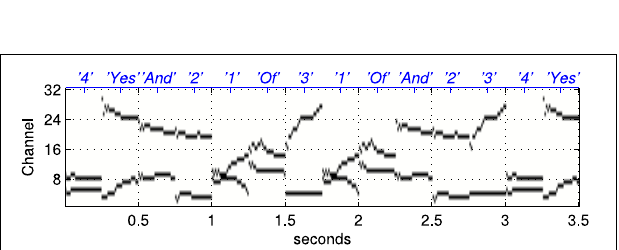
FIGURE 5 | An example of a stimulus sequence, or “sentence,” used as a Probe Stimulus ( PS ) for the second set of experiments in software simulations. The stimulus is a concatenation of simplified formant tracks drawn from the set of words illustrated in Figure 3 . The labels on the upper abcissa (in blue) show the stimulus class. Each “word” is arranged to be 250ms long, hence the presentation rate in the trials referred to as “normal” is 4 stimuli per second, see section